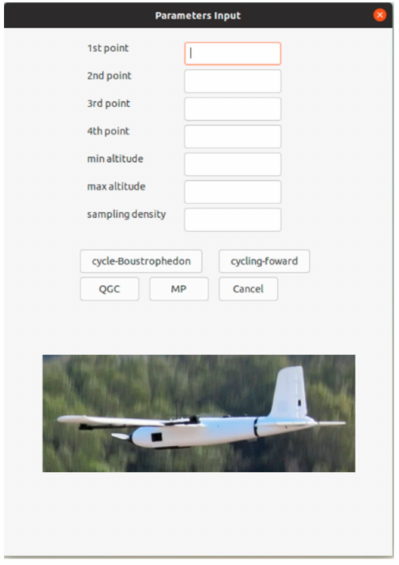
Figure 13. The designed GUI for air quality profiling coverage path planning.